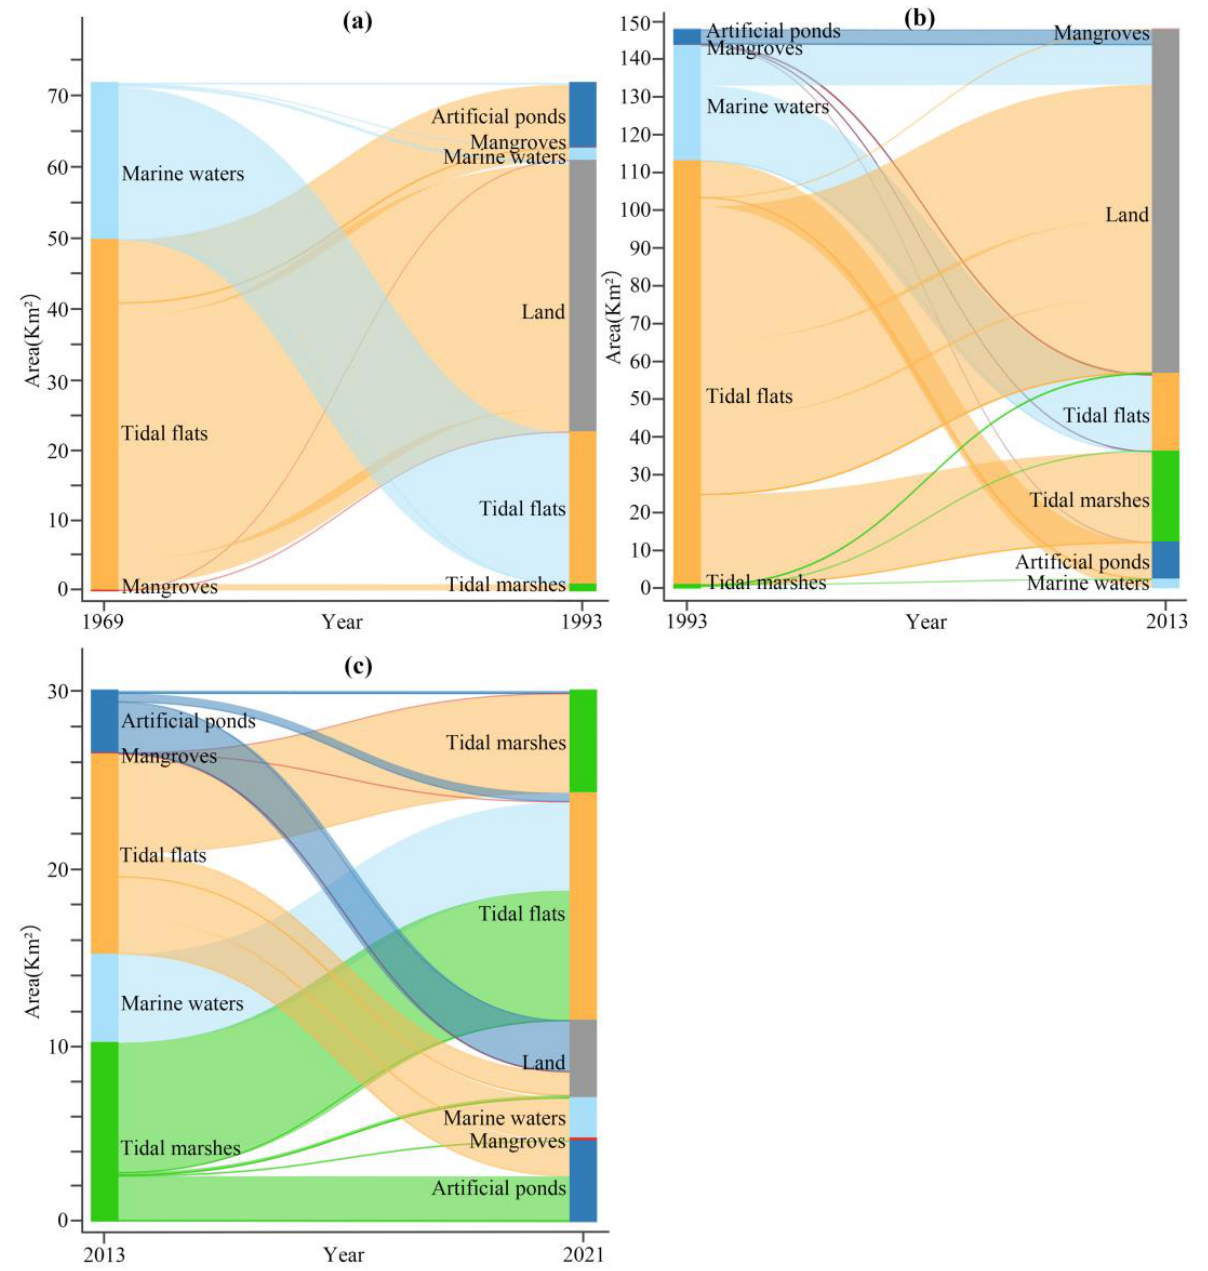
Figure 6. Sankey diagram of the transformations of the tidal wetland types. ( a )1969–1993. ( b ) 1993–2013. ( c ) 2013–2021.